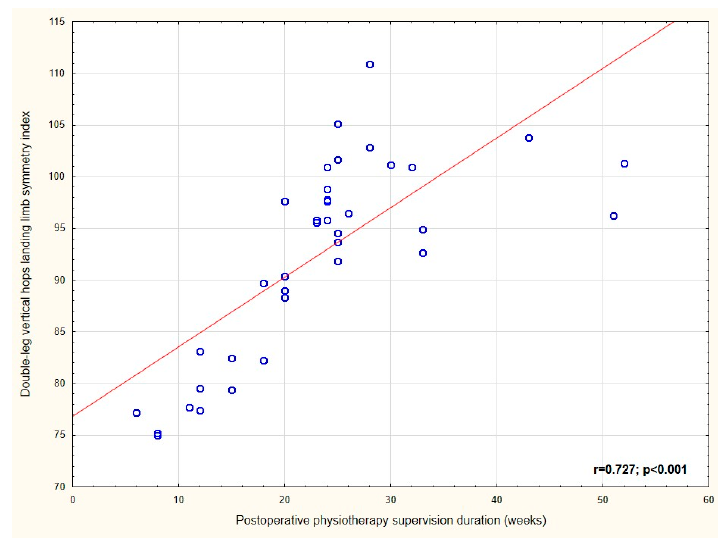
Figure 6. A significant positive correlation indicated that a higher limb symmetry index of vGRF BM during the double-leg vertical hop landing is associated with a longer duration of postoperative physiotherapy supervision in patients after ACLR.